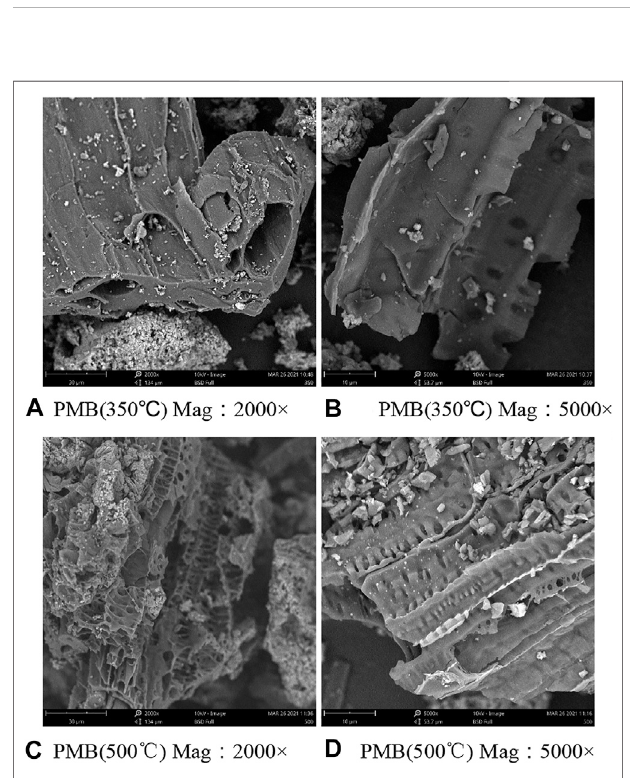
FIGURE 1 | SEM scanning of biochars with different